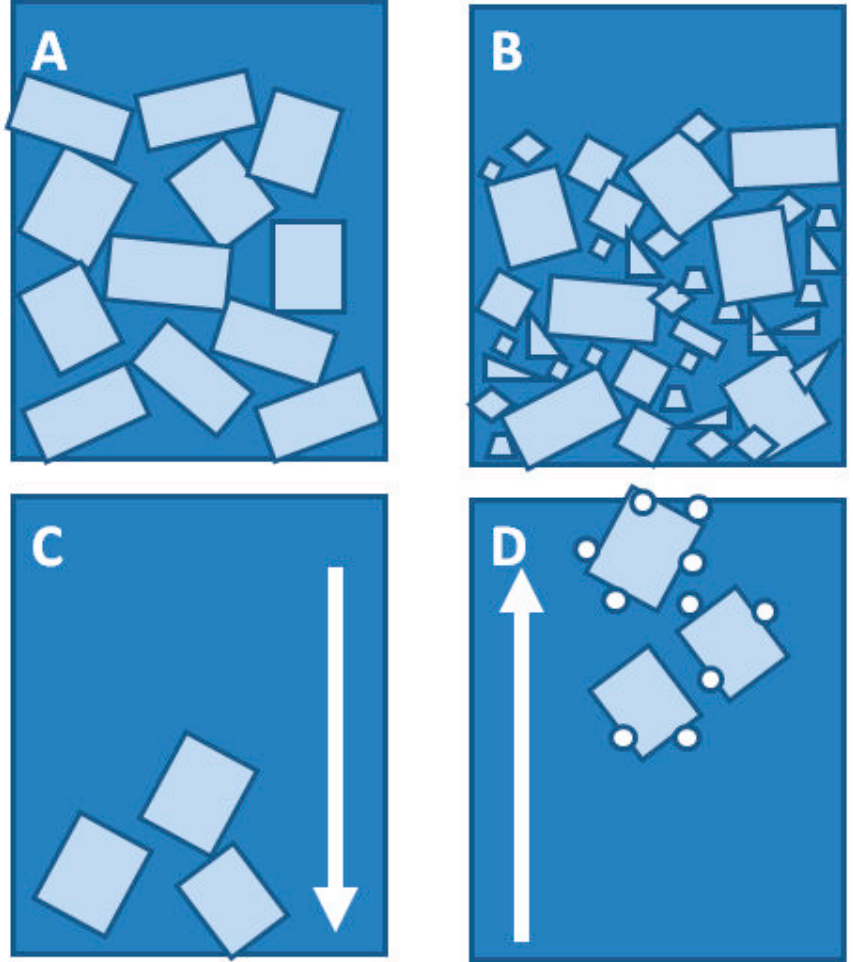
Figure 10. The mechanisms of packing and mobility of diatom frustules in an epoxy resin system. ( A )—Manner of packing for a narrow particle size distribution, ( B )—manner of packing for a wide particle size distribution (base diatoms), ( C )—filler sedimentation in a resin, and ( D )—filler floatation in a resin.